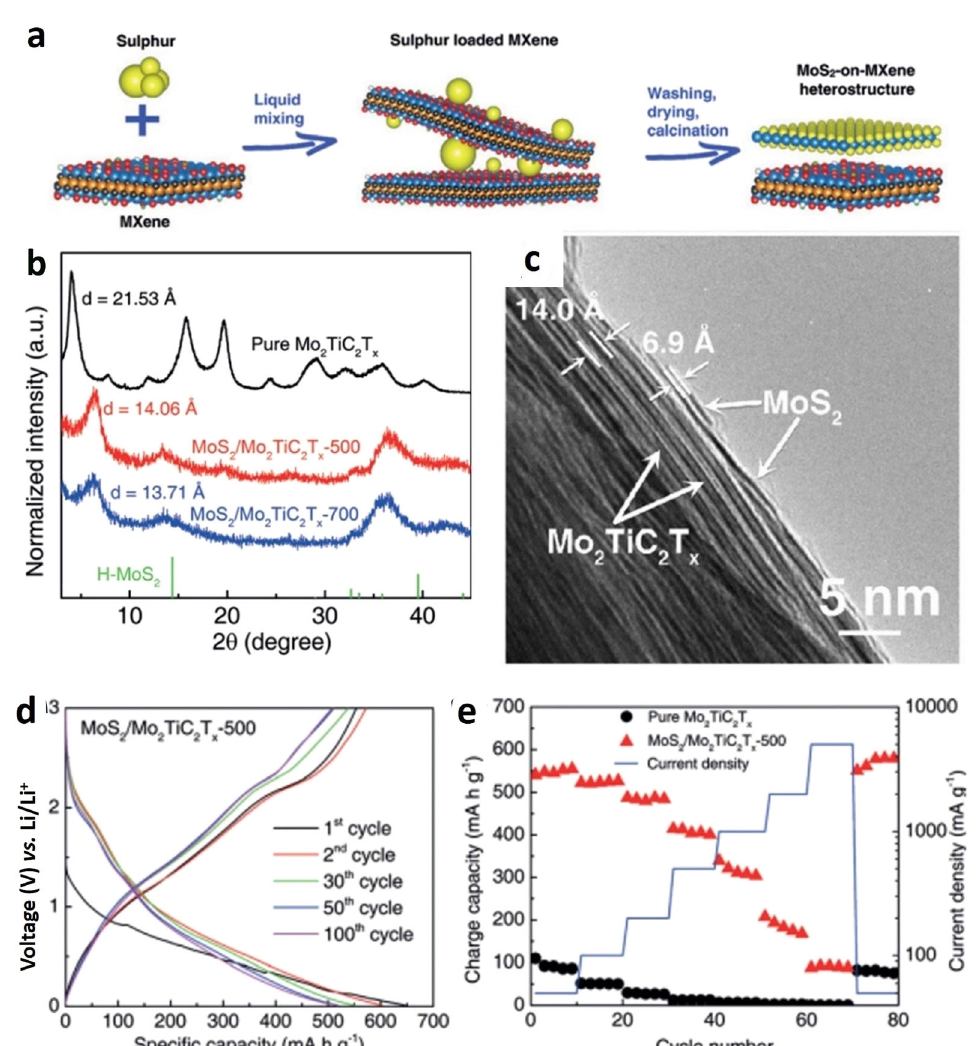
Fig. 10 Synergistic effect of MoS2/MXene composite. a Schematic diagram of the steps involved in the synthesis of MoS 2 /MXene composite; ( b ) XRD patterns of pure Mo 2 TiC 2 T x , MoS 2 / Mo 2 TiC 2 T x -500, and MoS 2 /Mo 2 TiC 2 T x -700; c TEM images of MoS 2 /Mo 2 TiC 2 T x -500 heterostructures in cross-sectional view; d GCD curves of MoS 2 /Mo 2 TiC 2 T x -500 at 100 mA g − 1 ; e Pristine Mo 2 TiC 2 T x and MoS 2 /Mo 2 TiC 2 T x -500 rate performance, Reprinted with permission from 135